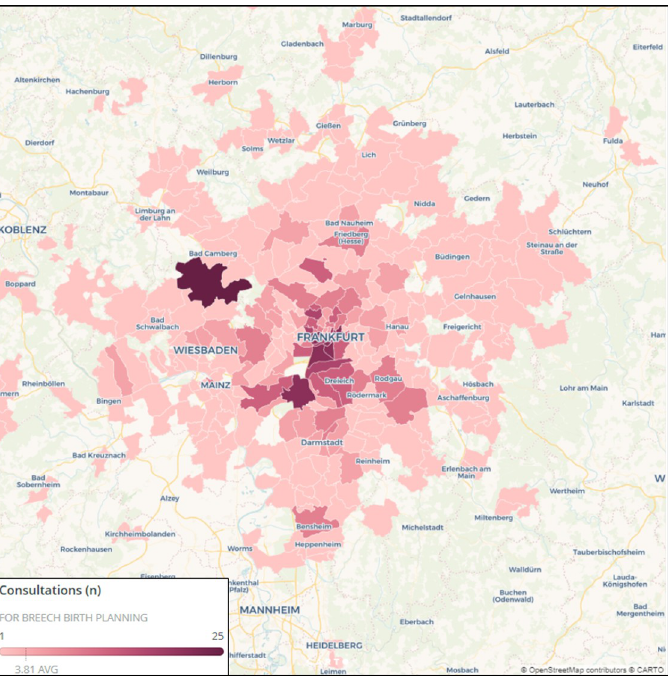
Fig 1. Hospital catchment area. Hospital catchment area for outpatient consultations for birth planning with breech presentation. Patients from areas outside of the depicted map were excluded. The number of consultations over 5 years is depicted for each zip code. Color was chosen at equal intervals. The map was created using CARTO and OpenStreetMaps. Reprinted from https://carto.com under a CC BY license, with permission from CARTO Legal, original copyright